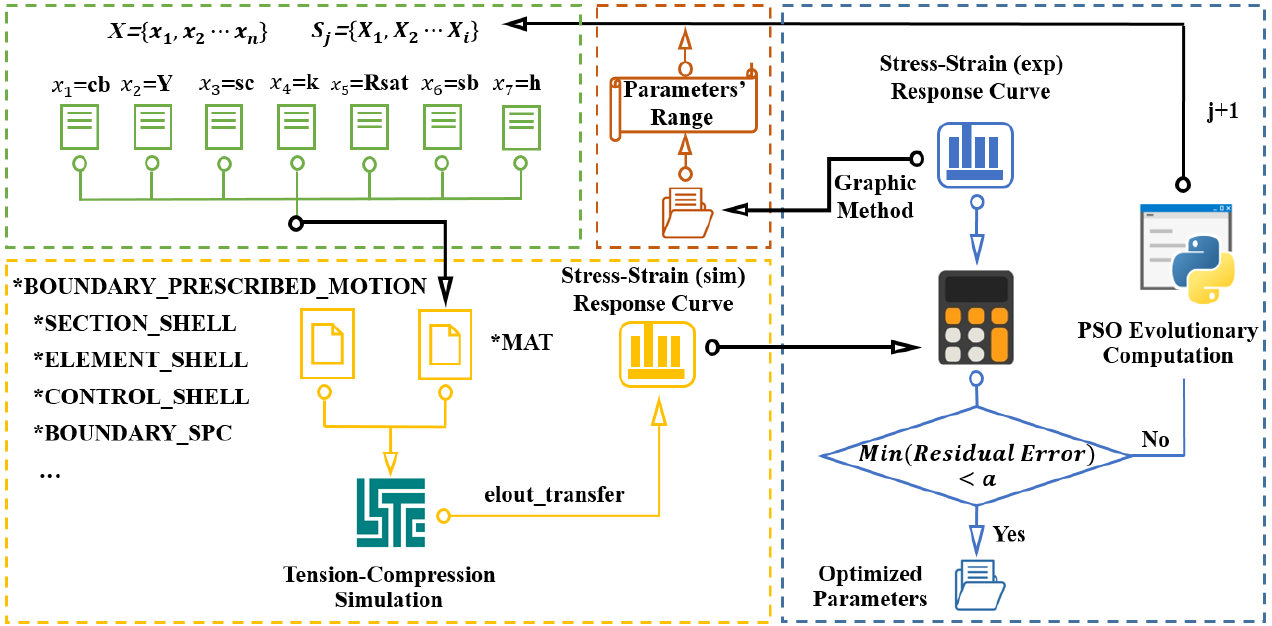
Figure 1. The Y-U hardening model parameters inversion procedure.